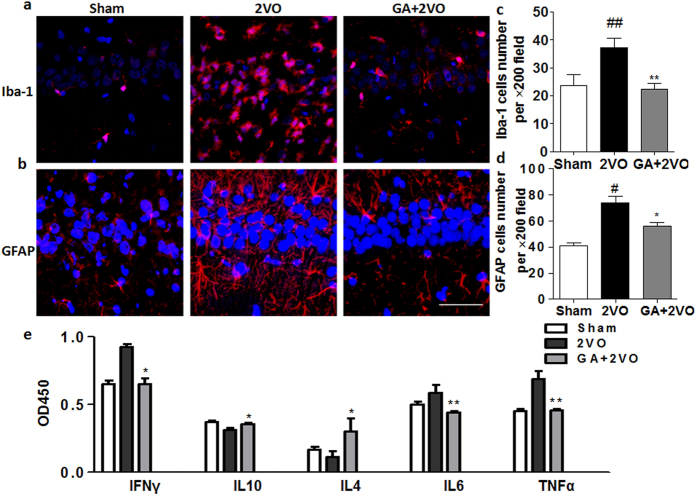
GA treatment attenuated inflammation induced by chronic cerebral hypoperfusion via modulation of the Th1/Th2 balance.(a,c) The expression of Iba-1 in the hippocampus, immunostaining for Iba-1 (red). (b,d) The expression of GFAP in the hippocampus of rats, immunostaining for GFAP (red). The expression of Iba-1 and GFAP was observed in all three treatment groups. The 2VO group showed increased gliosis compared to the sham group, whereas the GA treatment group showed a decreasing expression of Iba-1 and GFAP compared to the 2VO group (P < 0.01 and P < 0.05, respectively) (magnification 200×). Scale bar = 50 μm. (e) ELISA measurement of cytokine profiles. The concentrations of IFN-γ, IL-4, IL-10, IL-6, TNF-α were determined in supernatants of hippocampal tissues by ELISA. Amounts of IFN-γ, IL-6 and TNF-α were inhibited, but levels of IL-4 and IL-10 in the GA-treatment group exceeded those in the 2VO group, although not to a significant extent compared with the sham group. n = 4. Data were analyzed by ANOVA. Means are shown ± SEM (*P < 0.05 and **P < 0.01 as compared to 2VO group).